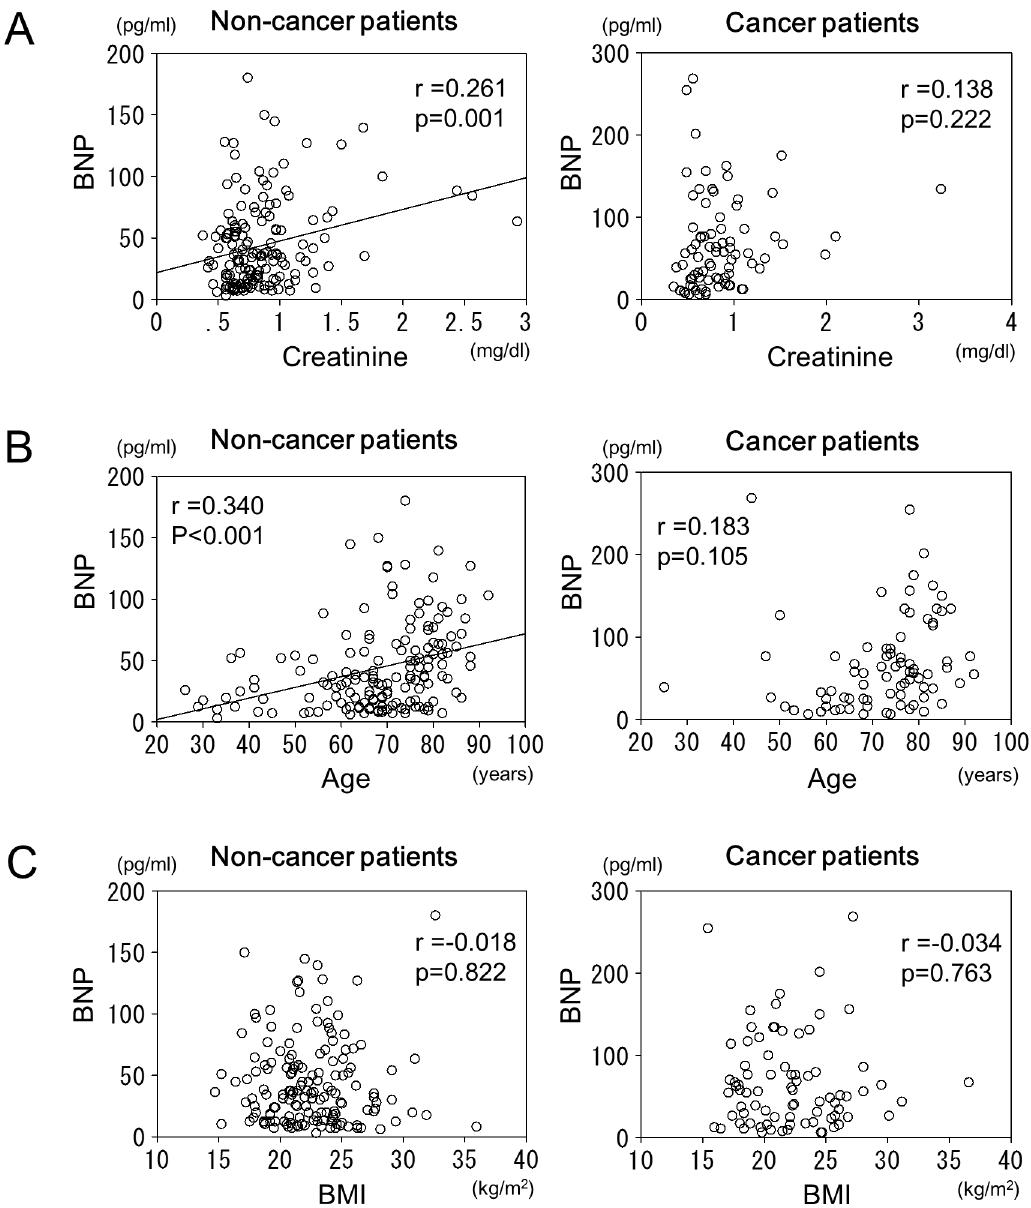
Fig 4. A. Relationship betweenthe BNP and creatininelevels in the patients with and without cancer. In the non-cancer patients, there was a significantcorrelationbetweenthe BNP and creatininelevels, but there was no correlationbetween the BNP and creatininelevels in the cancer patients. B. Relationship betweenthe BNP and age in the patients with and without cancer. In the non-cancer patients, there was a significantcorrelation betweenthe BNP level and age, but that correlationwas not observedin the cancer patients. C. Relationship betweenthe BNP and body mass index in the patients with and without cancer. There was no significantcorrelationbetweenthe BNP levels and body mass index in either the patients with cancer or those